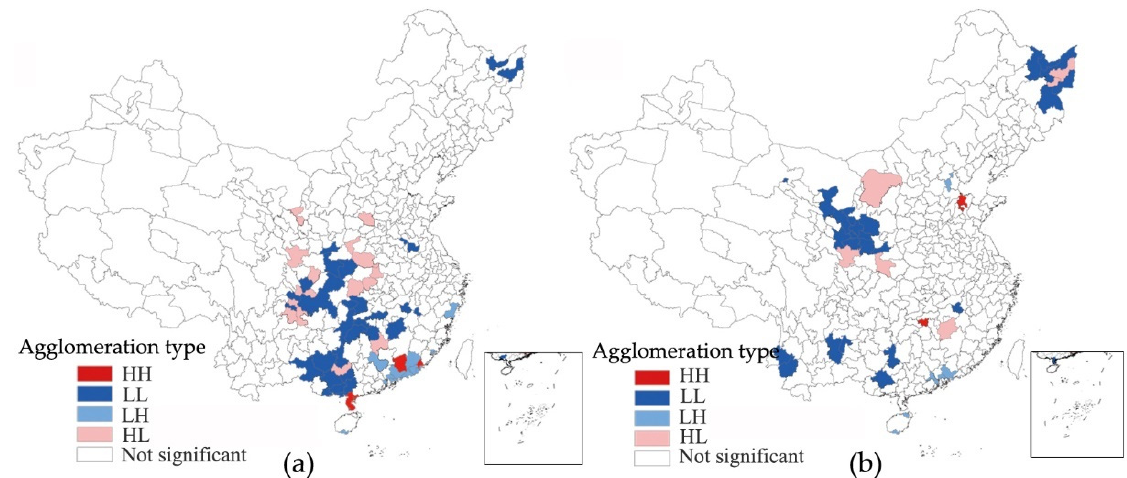
Figure 5. Bivariate LISA clustering of the LP index. ( a ) Spatial lag of the local protection index in 2004; ( b ) spatial lag of the local protection index in 2011.